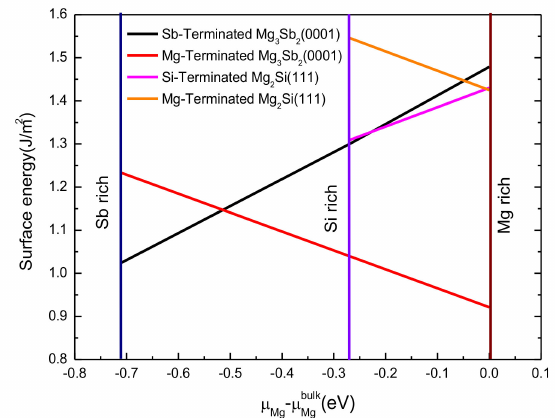
Figure 4. Calculated surface energy of Mg 2 Si (111) and Mg 3 Sb 2 (0001) as a function of the magnesium chemical